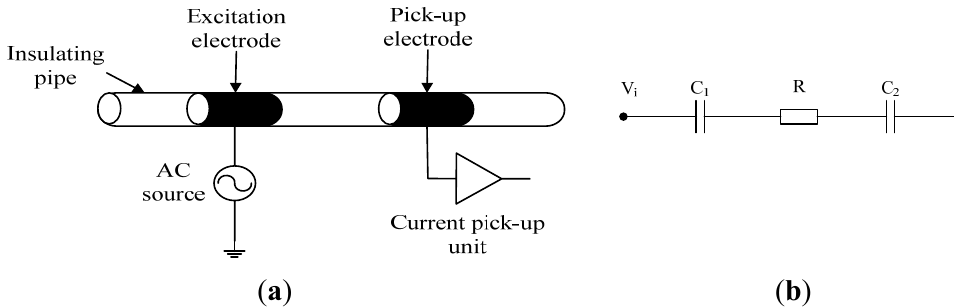
Figure 1. Principle of C 4 D technique. ( a ) Construction of conventional C 4 D sensor. ( b ) Simplified equivalent circuit of conventional C 4 D